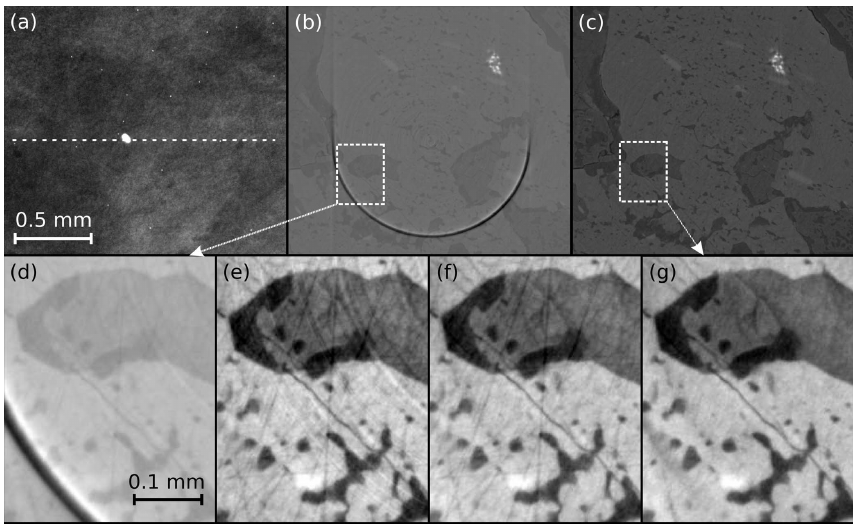
Figure 6 Reconstruction of parallel beam CT data with tofu ez . The sample is metamorphic schist (a piece of rock composed of four minerals). The top row shows from left to right fragments of: a raw CT projection ( a ) (dashed line indicating reconstructed row); of a slice reconstructed from phase- retrieved projections without the application of any artifact-reduction algorithms ( b ); of the same slice reconstructed with suppression of artifacts ( c ). Magnified fragments of images ( b ) and ( c ) are shown in insets ( d ) and ( g ), respectively. Images in the bottom row demonstrate progressive improvement when: only phase-retrieval was applied to data ( d ); phase-retrieval and broad ring removal ( e ); phase-retrieval, broad and narrow ring removal ( f ); all previous algorithms were applied and the outliers were removed from projections and flat-field images ( g ). Panels ( a ) and ( d )–( g ) have been inserted after automatic contrast adjustment was applied in ImageJ once to the entire image; no image correction of any kind was applied to panels ( b , c ). The scalebar for all images in a row is the same as shown in the heading image of that